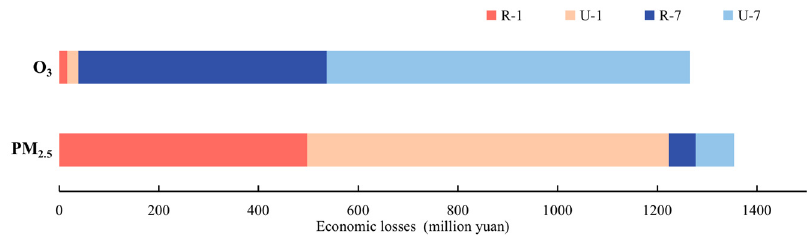
Figure 11. Economic losses caused by pollutants in urban (U) and rural (R).